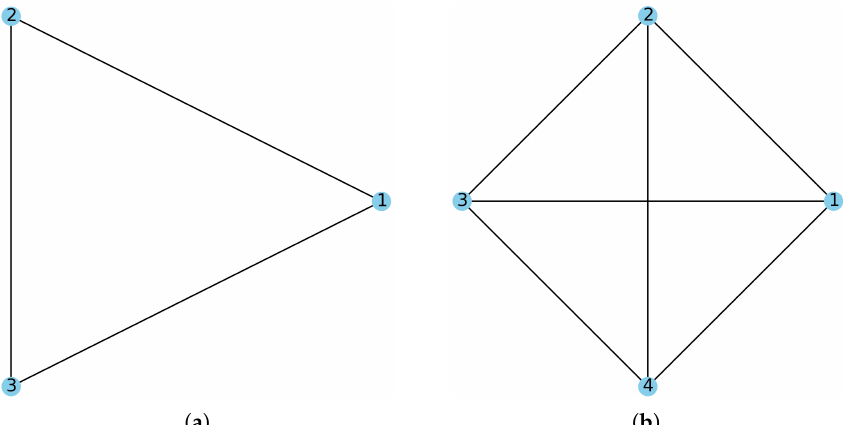
Figure 1. Example Networks with Specific Nodes. ( a ) is composed of nodes 1, 2 and 3, and ( b ) is composed of nodes 1, 2 , 3, and 4. Example networks are composed of a specific node (1) and its first-order neighbor nodes, which form fully connected subgraphs. ( a ) Undirected Network G 1 ; ( b ) Undirected Network G 2 .